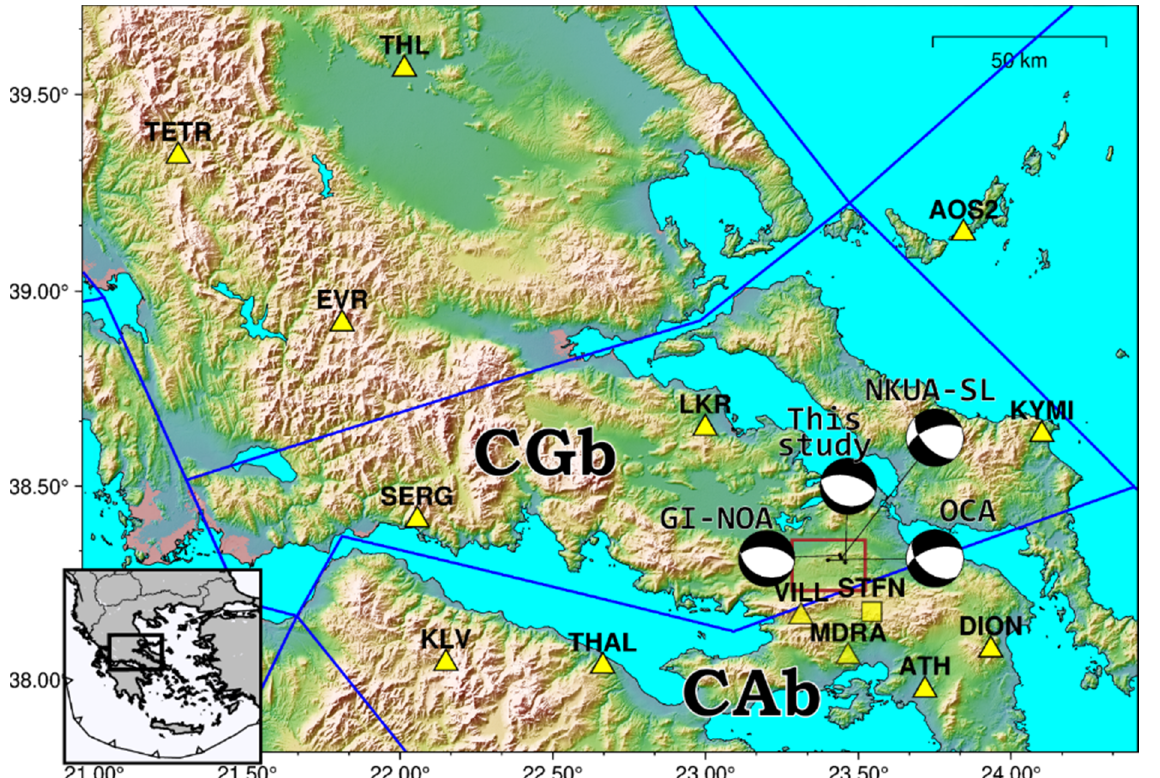
Figure A6. Sites of the stations used in the inversion (triangles for broadband sensors and squares for short-period) for determining the focal mechanism. The three closest rejected stations (MDRA, STFN and VILL, in faded color) are also shown. Beachballs for the solutions of this study, NKUA-SL, GI-NOA and OCA are plotted, with lines pointing to the centroid coordinates provided by each research team. Blue lines bound the blocks proposed by [7]. The study area of Figure 5 (brown rectangle) is noted. Inset: location of the area shown in the main map (dashed black line) in Greece.